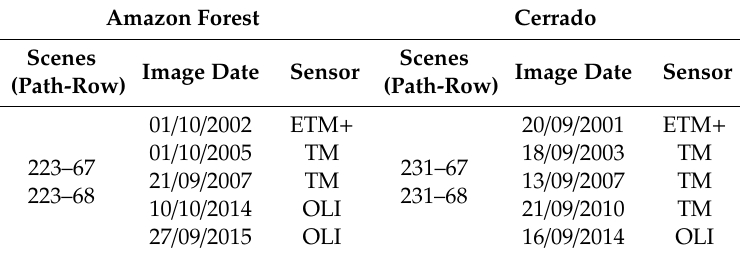
Table 2. Landsat database used to define the best threshold for mapping of burned areas, considering the sensors: Thematic Mapper (TM), Enhanced Thematic Mapper Plus (ETM + ), and Operational Land Imager